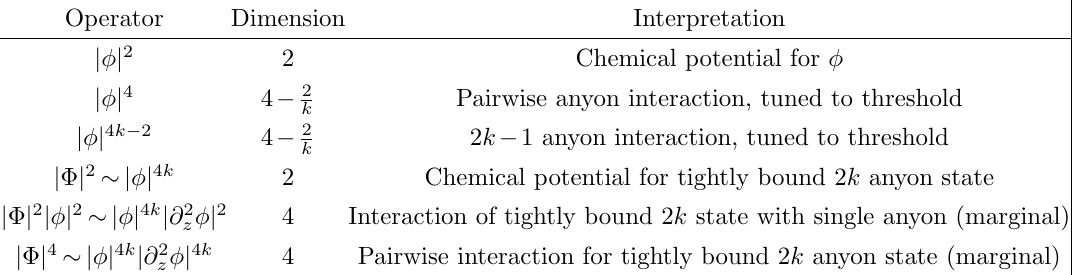
Table 1 . Relevant and marginal linear operators at the supersymmetric fixed point for k >